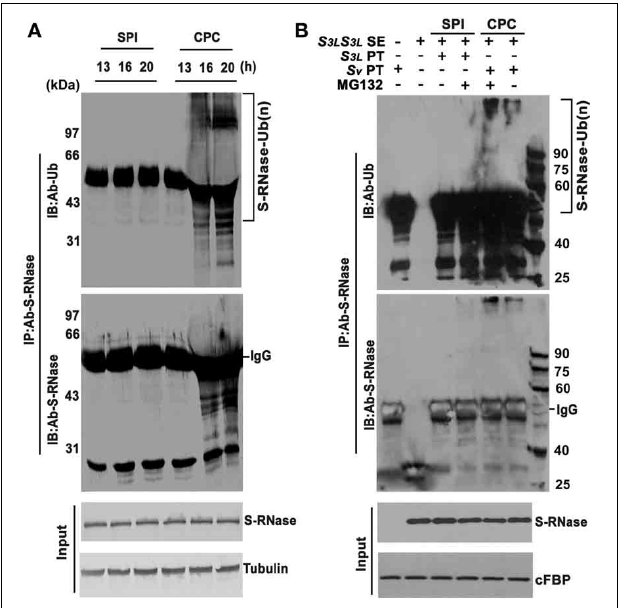
FIGURE 4 | S-RNases are polyubiquitinated in compatible pollen tubes. (A) PhS-RNases are polyubiquitinated in pollen tubes of compatible pollination. Pollen tubes were dissected from styles after 13, 16, and 20h post-pollination. Samples extracted and immunoprecipitated by PhS-RNase antibody and detected by ubiquitin (Ub) antibody and PhS-RNase antibody. PhS-RNase and tubulin were detected as input and loading control. (B) PhS-RNases are polyubiquitinated in CPC response in in vitro pollen germination system. In vitro germinated S 3L (SPI) and S v (CPC) pollen tubes challenged by S 3L S 3L style extract were subjected to MG132 treatment ( + ) or not ( − ). Samples of SPI, CPC, and CK were immunoprecipitated by PhS-RNase antibody and detected by ubiquitin (Ub) antibody and PhS-RNase antibody, respectively. Style extracts and immunoprecipitation of the untreated pollen tubes samples were used as negative controls. Challenged but not immmunoprecipitated pollen tube samples were loaded as input. PhS 3L -RNase and cFBP were detected as input and loading control. S-RNase-Ub (n) denotes polyubiquitinated S-RNase. IgG indicates heavy chain. Molecular weights in kilodalton (kDa) are shown on right or left side of the